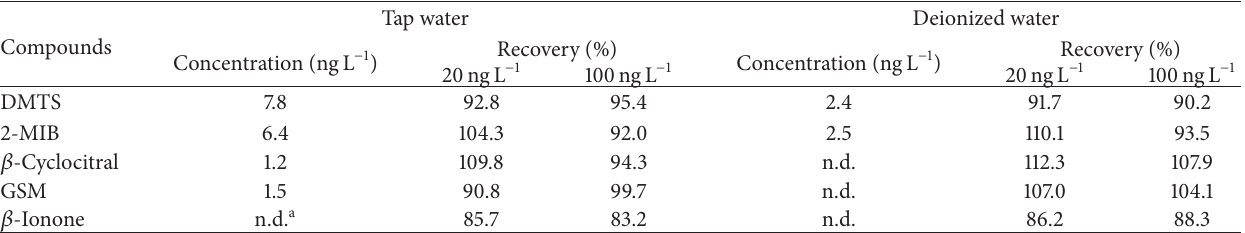
Table 3: The concentration and recovery of earthy and musty odors in water samples (all samples were tested two times). Tap water Deionized water Compounds Concentration (ngL − 1